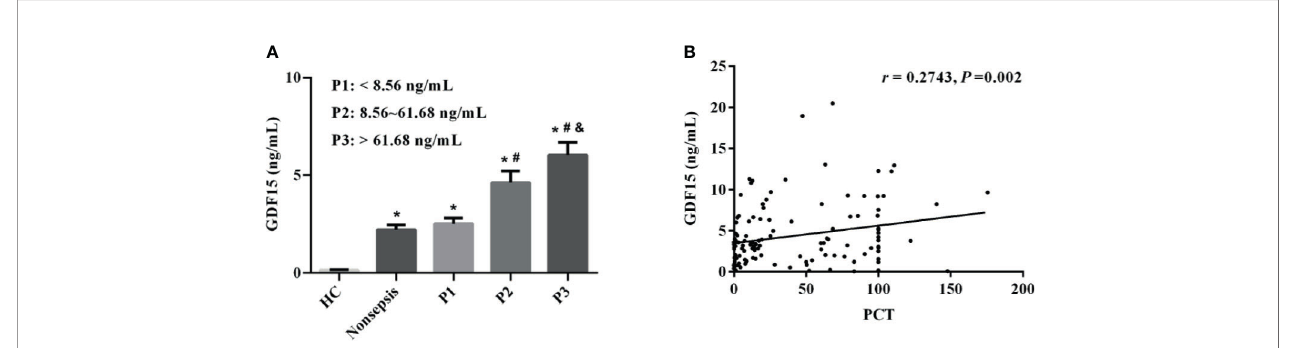
FIGURE 2 | Correlation between GDF15 and PCT levels in patients with sepsis. (A) comparison of GDF15 levels in sepsis patients with different PCT levels; (B) Spearman correlation analysis of PCT and GDF15 levels. * P < 0.05, compare with HC group; # P < 0.05, compare with P1 group; & P < 0.05, compare with P2